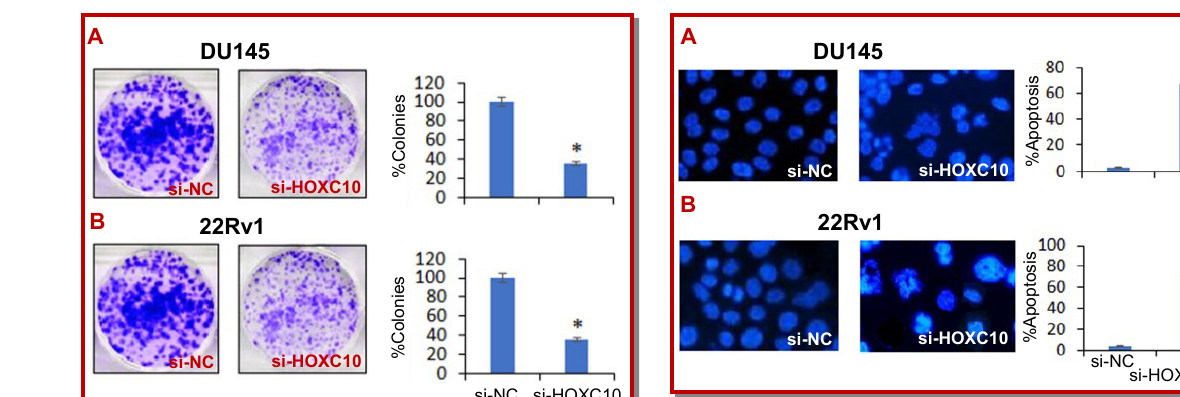
Figure 3: Transcriptional repression of HOXC10 inhibited the colony forming potential of prostate cancer cells. (A) Colony forming assay showing the percentage of the colonies formed in si-NC and si-HOXC10 transfected DU145 prostate cancer cells; (B) Colony forming assay showing the percentage of the colonies formed in si-NC and si-HOXC10 transfected 22Rv1 prostate cancer cells. The experiments were performed in trip- licates and expressed as mean ± SD (*p<0.05)